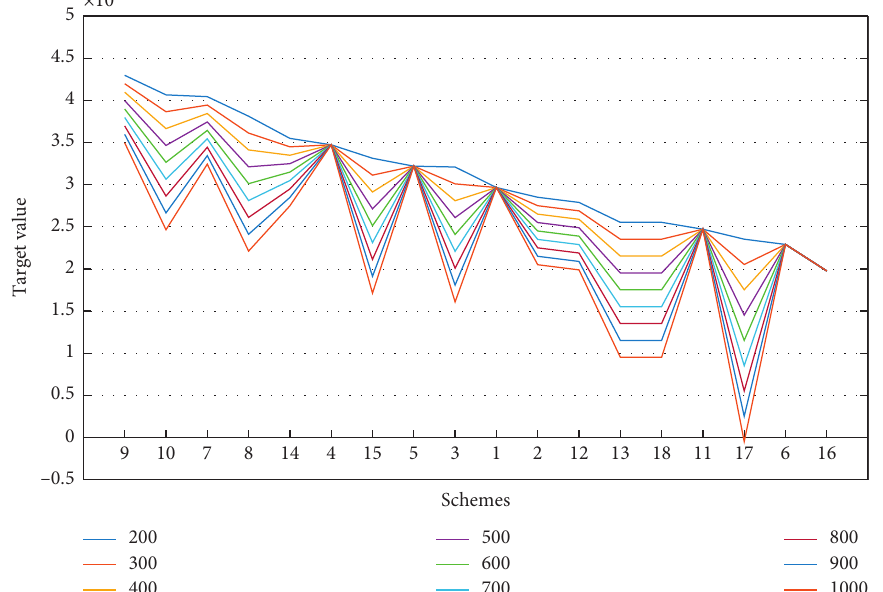
Figure 9: C � 2: target values of various schemes under different train adjustment cost coefficients of existing trains. z